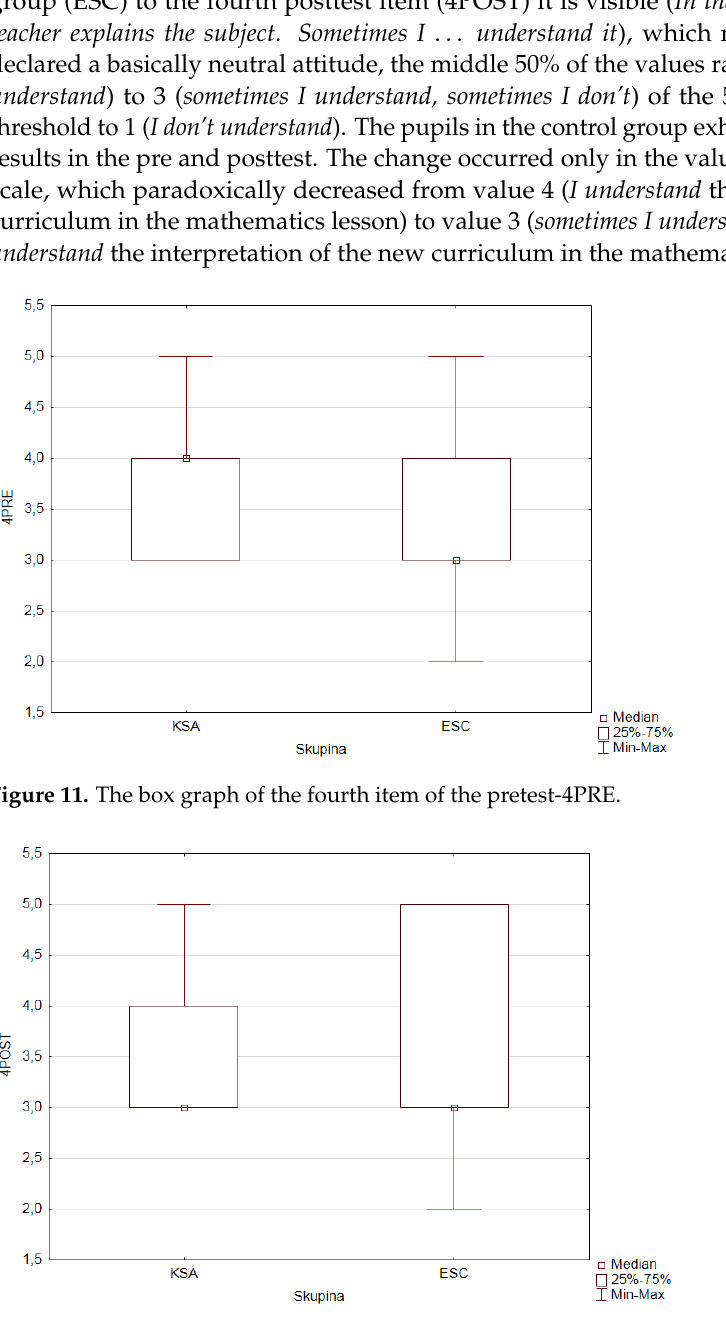
Figure 13. The box graph of the ninth item of the pretest - 9PRE.